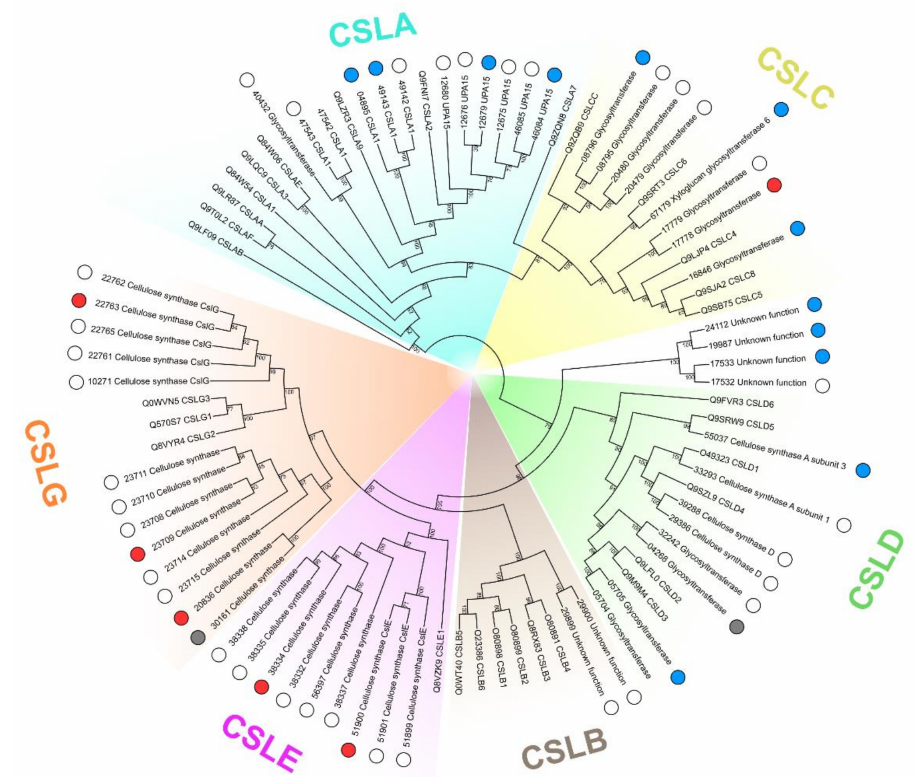
Figure 9. Phylogeny of potato cellulose synthase-like (CSL) proteins (glycosyltransferase 2 family, GT2) and of a reference set of Arabidopsis thaliana CSLs. The clades for GT2 functional subgroups are marked in colors. Potato proteins are indicated with circles according to the expression pattern of the corresponding genes in Pectobacterium atrosepticum -infected vs. non-infected potato plants: red—upregulated; blue—downregulated; grey—non-DEG; empty—not expressed in our study. The UniProt IDs of A. thaliana proteins are given in leaf names. For potato proteins, only parts of PGSC IDs are given; the “PGSC0003DMP4000” symbols, the constant part at the beginning of all presented PGSC protein IDs, were omitted for the sake of